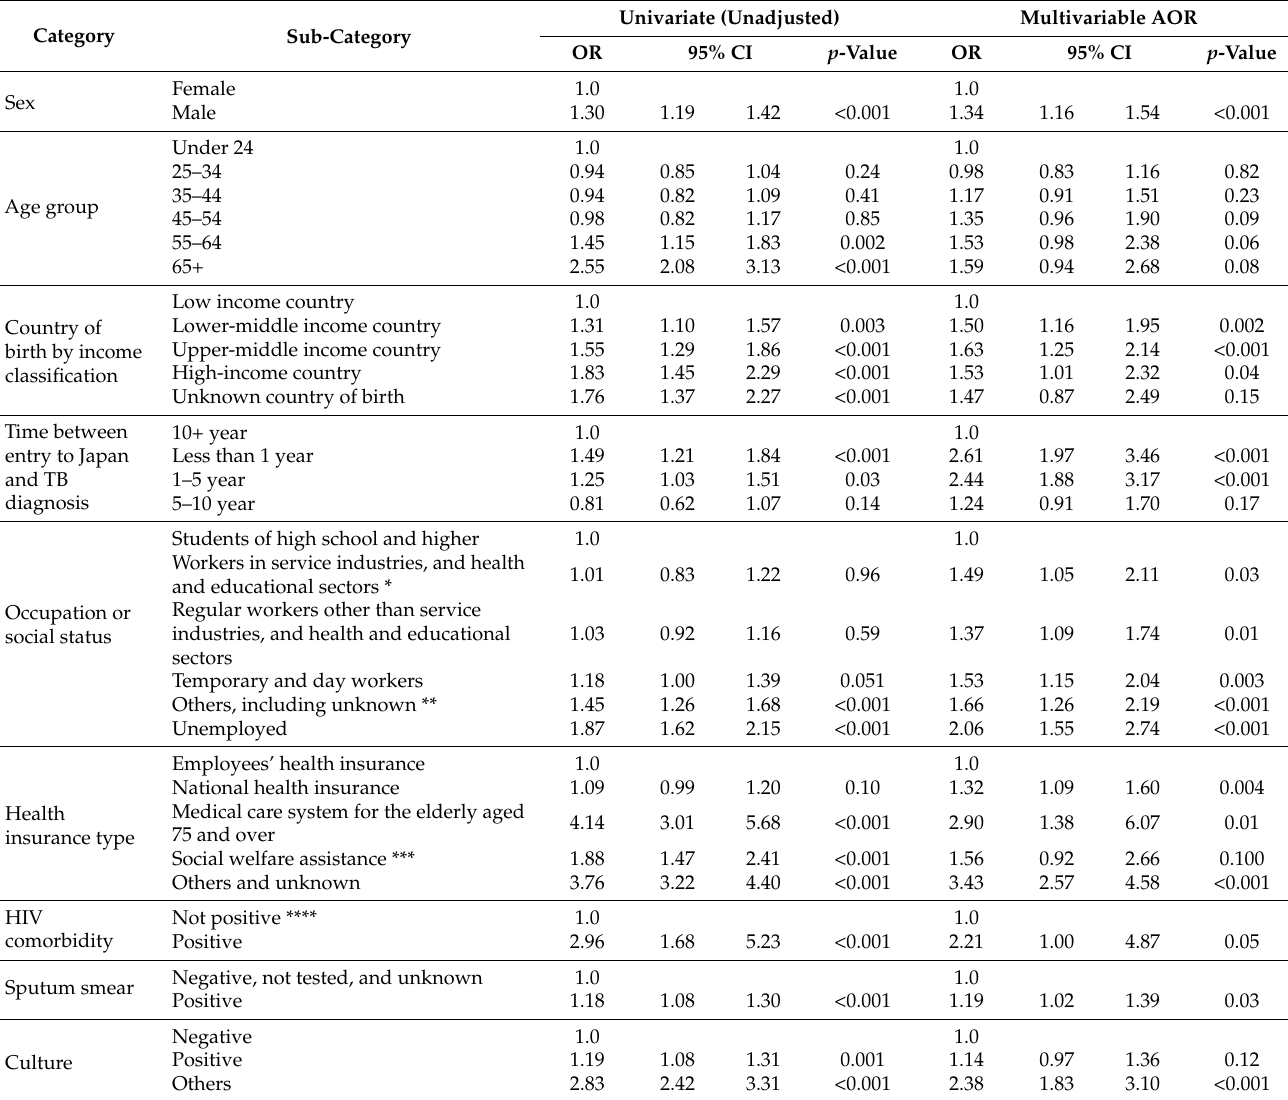
Table 3. Multiple logistic regression of risk factors associated with treatment non-success among overseas-born patients with pulmonary tuberculosis in